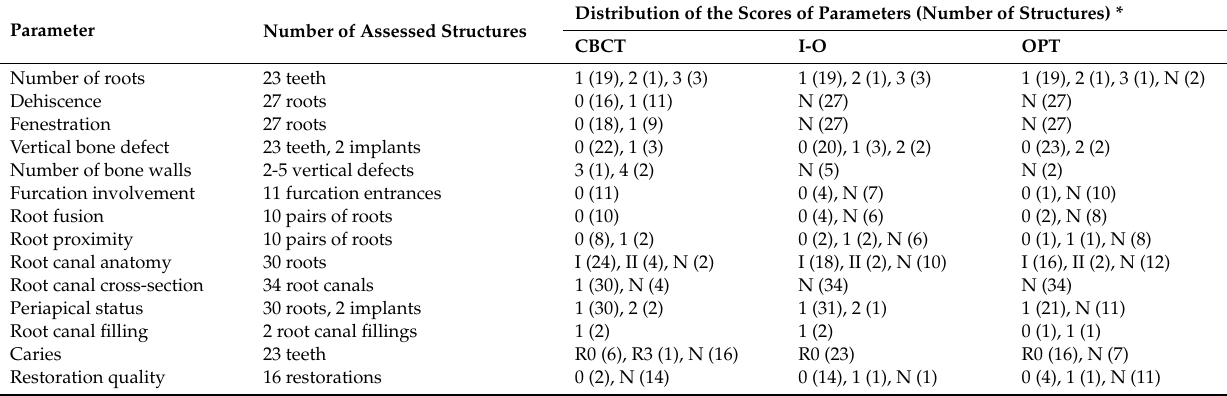
Table 2. Number of assessed structures and distribution of the scores of dental and periodontal